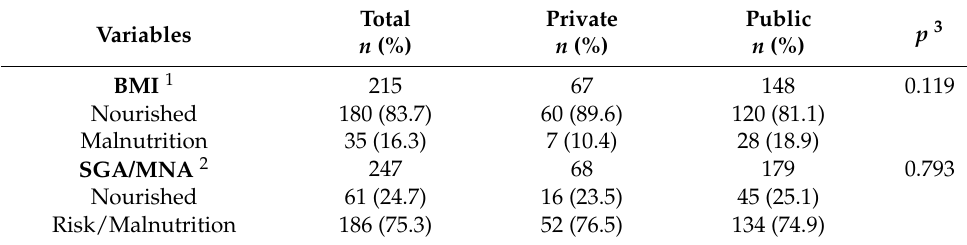
Table 2. Comparison of the frequency of malnutrition among hospitalized patients with heart failure in the public and private health systems in Brazil, from April 2018 to January